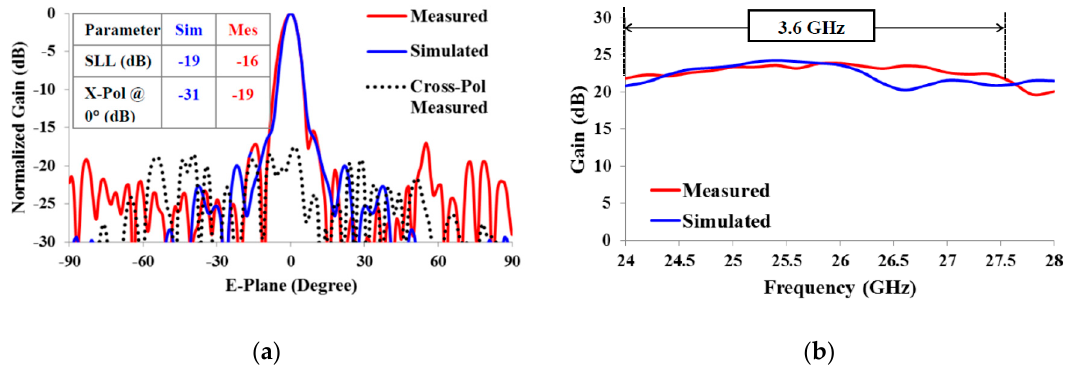
Figure 11. Horizontally polarized results of asymmetric patch reflectarray with embedded ground slots for mirror elements ( a ) Radiation pattern at 26 GHz ( b ) Gain versus frequency response.